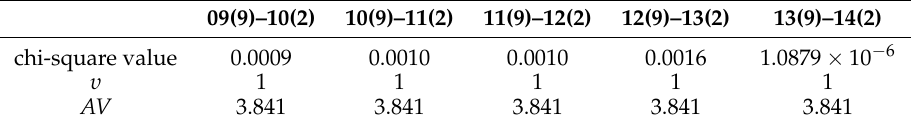
Table A4. Chi-square values and degrees of freedom for the latter half of the year (LHY, e.g., 09(9)–10(2) stands for September of 2009 to February of 2010, and υ denotes degrees of freedom and AV denotes the accepting value at a 5% significant level with degrees of freedom